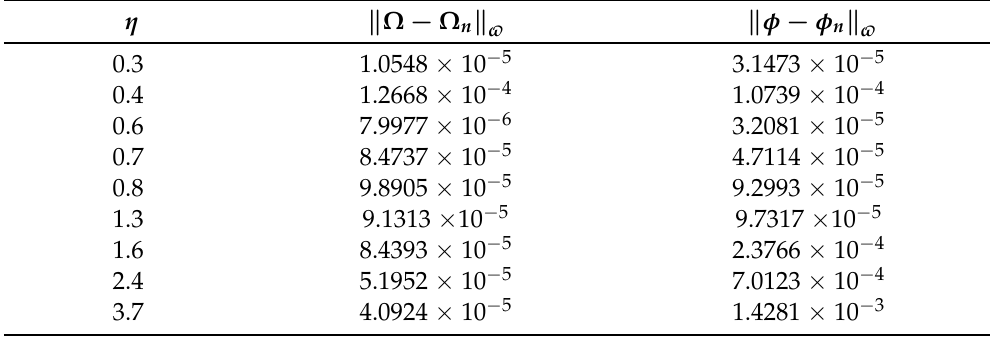
Table 2. Influence of fractional order η on the approximate